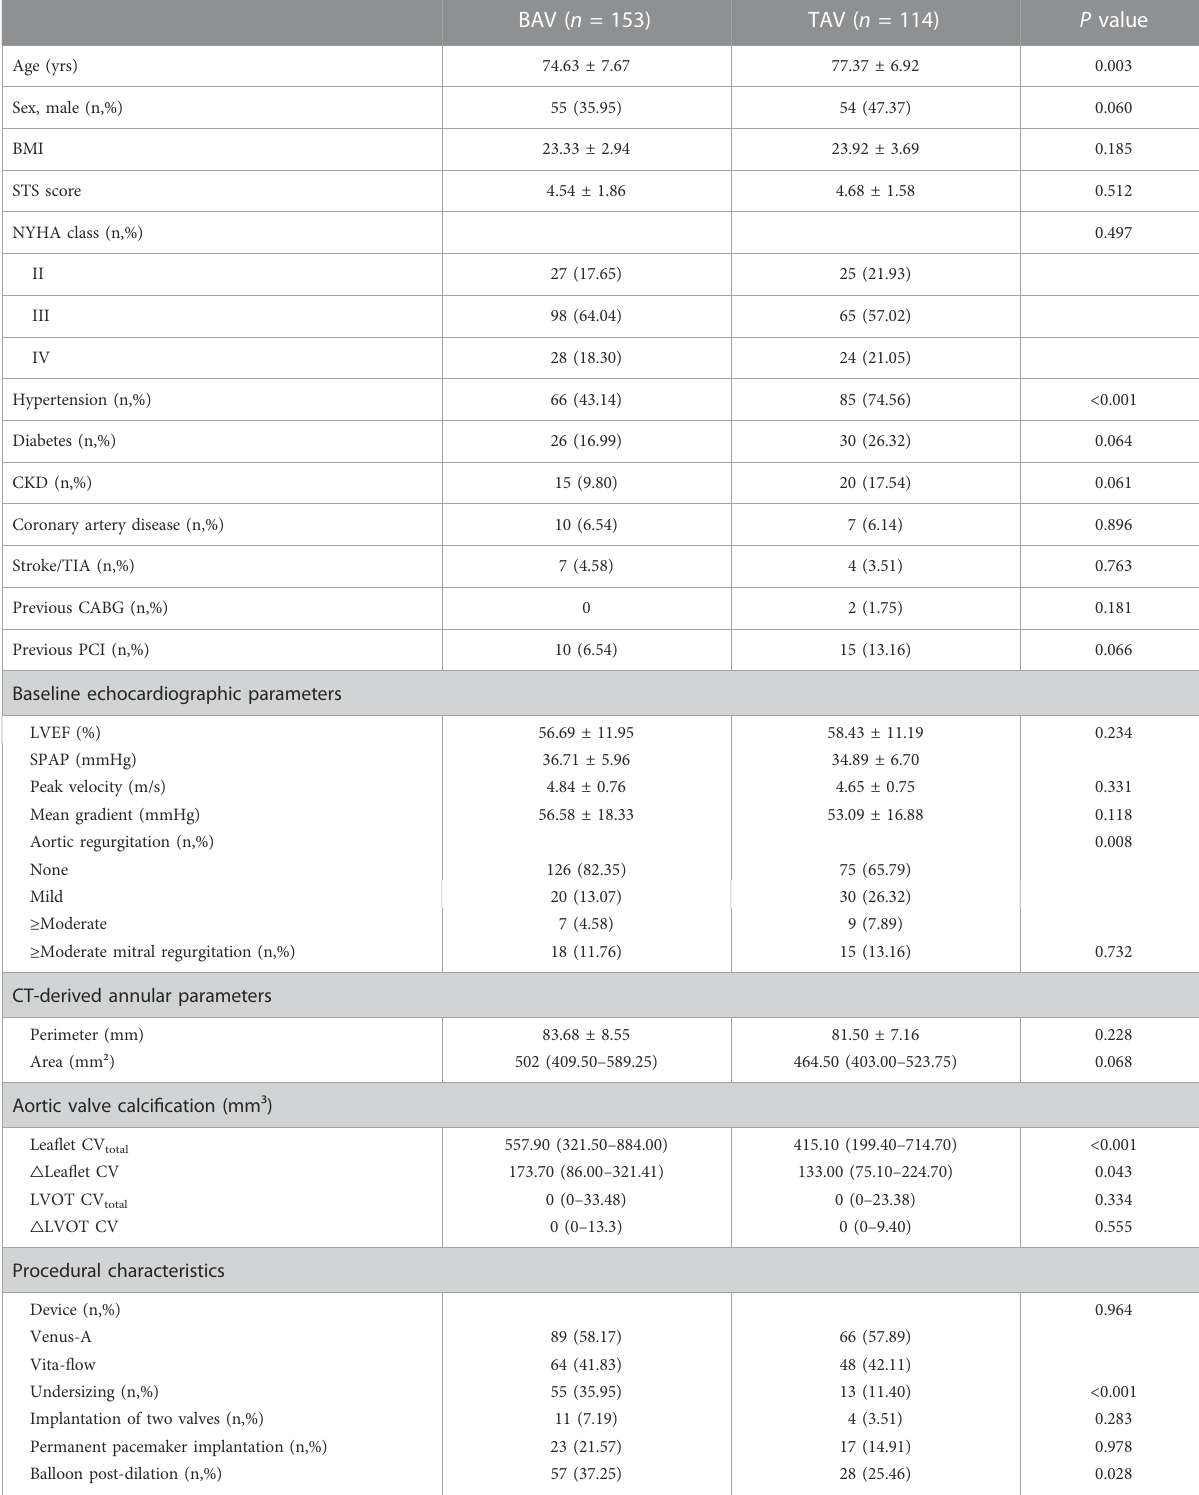
TABLE 1 Baseline